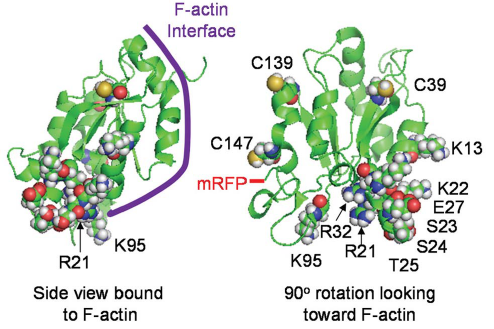
Figure 2. Cofilin structure and position of residues for which site directed mutants were made. Side view of cofilin model created in PyMOL showing approximate F-actin binding interface for both upper and lower subunit contacts, and a rotated view showing the position of the residues for which mutants were made, as well as the C- terminal residue through which the mRFP is